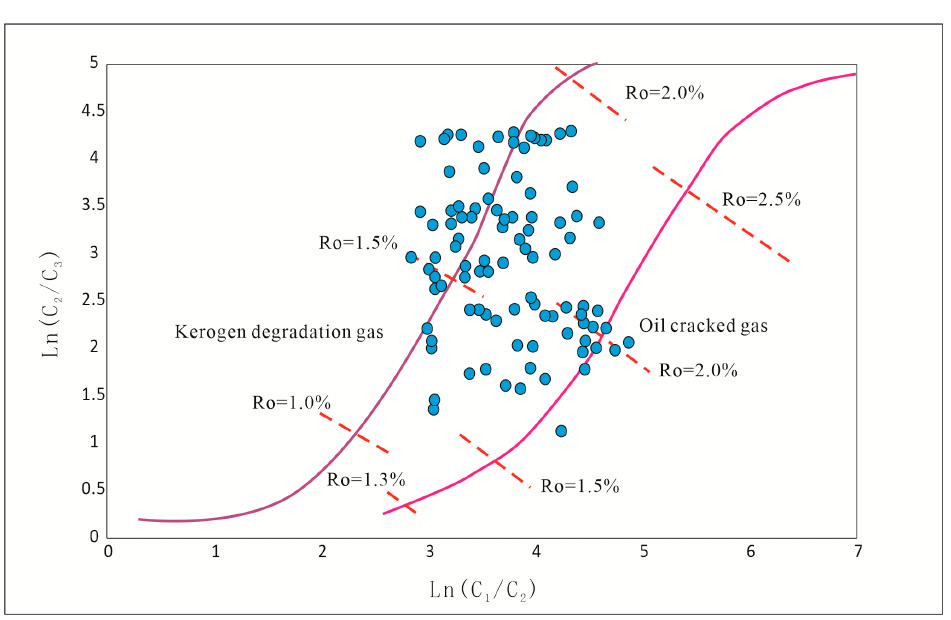
Figure 15. Recognition plate of natural gas in the Tonghua Basin, adapted from [40]